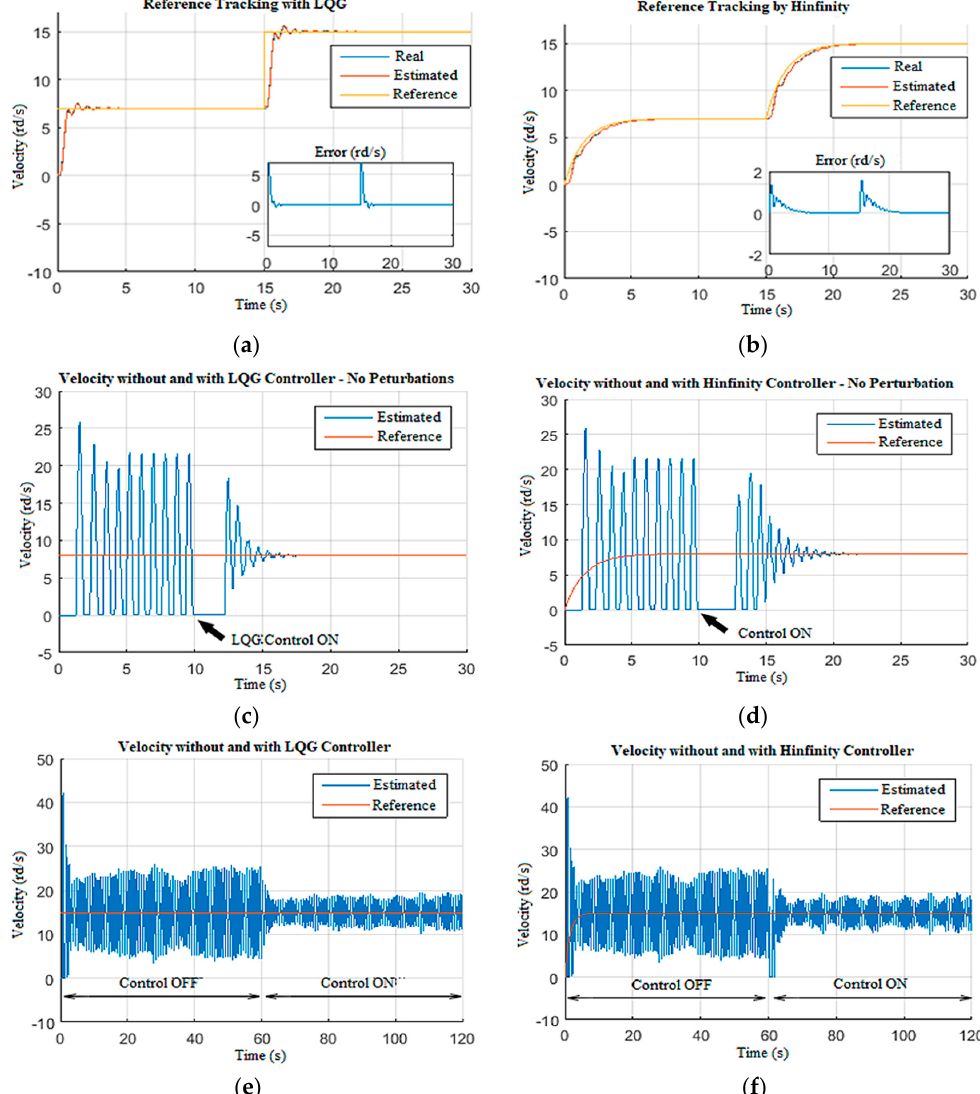
Figure 25. Comparison between LQG and H ∞ responses: ( a ) reference tracking with LQG; ( b ) refer- ence tracking with H ∞ ; ( c ) drill bit velocity by LQG without disturbances; ( d ) drill bit velocity by H ∞ without disturbances; ( e ) drill bit velocity by LQG under structured disturbances; ( f ) drill bit velocity by H ∞ under structured disturbances.